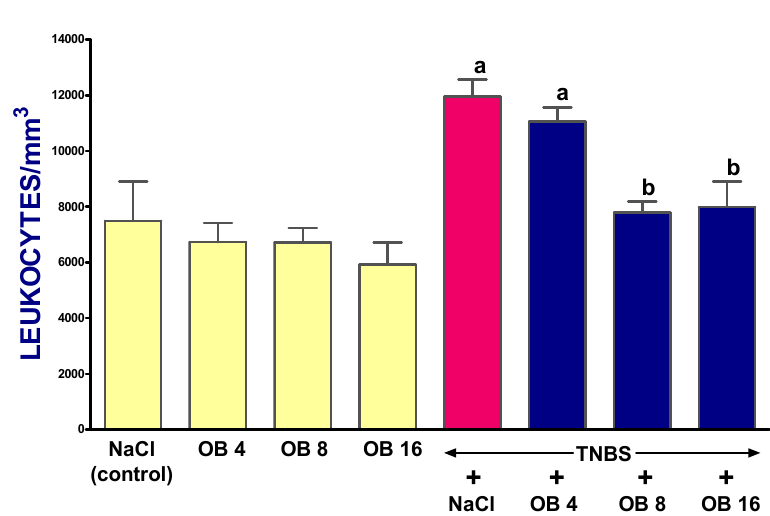
Figure 6. Effect of saline (NaCl) or obestatin given at doses of 4 nmol/kg (OB4), 8 nmol/kg (OB8), or 16 nmol/kg (OB16), and induction of TNBS-induced colitis on the number of blood leukocytes. Mean ± SEM. n = 10 in each group of animals. a p < 0.05 when compared with control; b p < 0.05 when compared with colitis + NaCl.